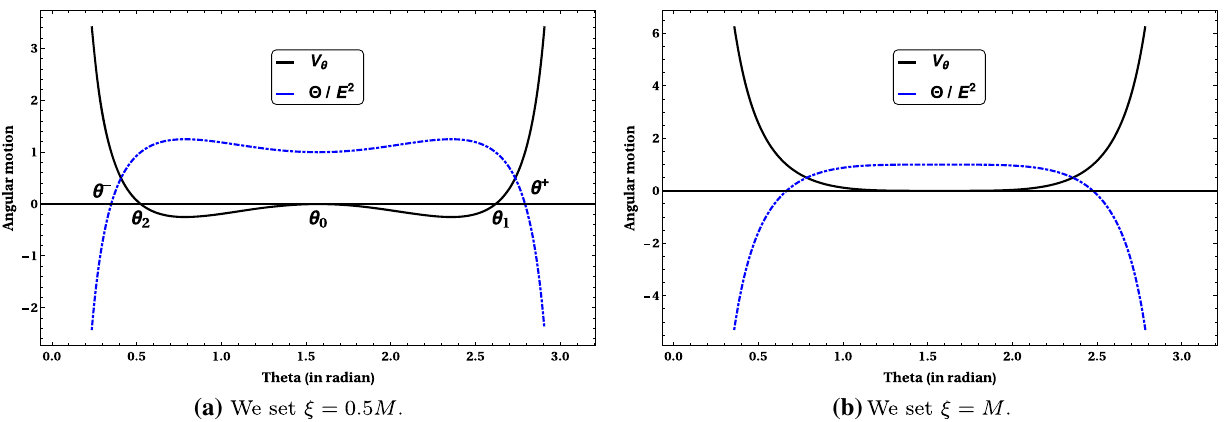
Fig. 6 The angular potential and momentum associated with the angular motion of a massless particle in Kerr–Newman spacetime has been presented with non-zero Carter constant: λ = M 2 and rotation parameter: a = M